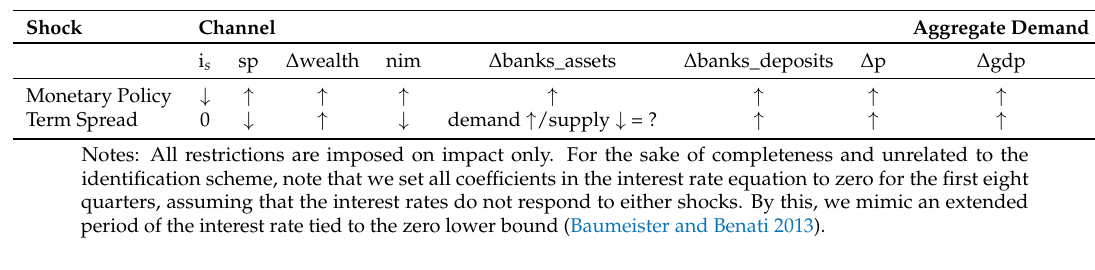
Table 1. Identification via sign